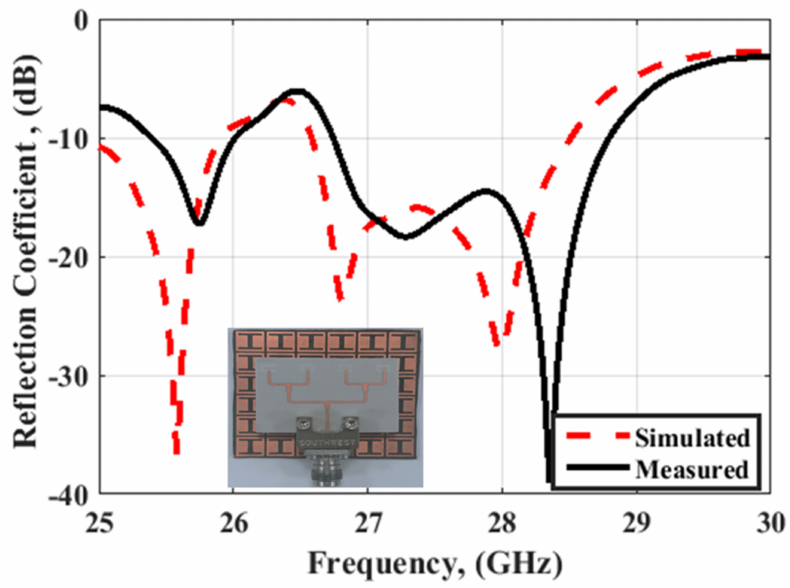
Figure 15. Reflection coefficient of the embedded antenna with